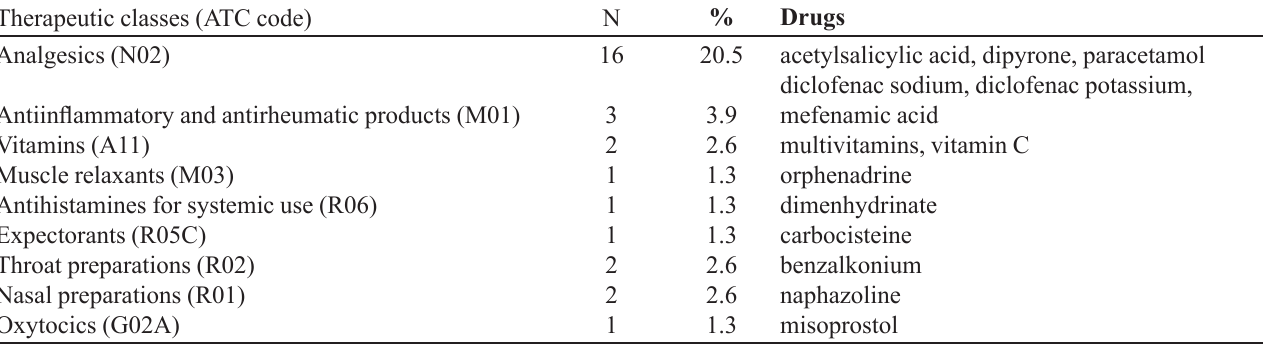
TABLE IV – Distribution of drugs used for self-medication during gestation, according to the Anatomical Therapeutic Chemical Classification System (ATC), used by puerperal women interned in HC / UFPE after high-risk pregnancy, 2011 Therapeutic classes (ATC